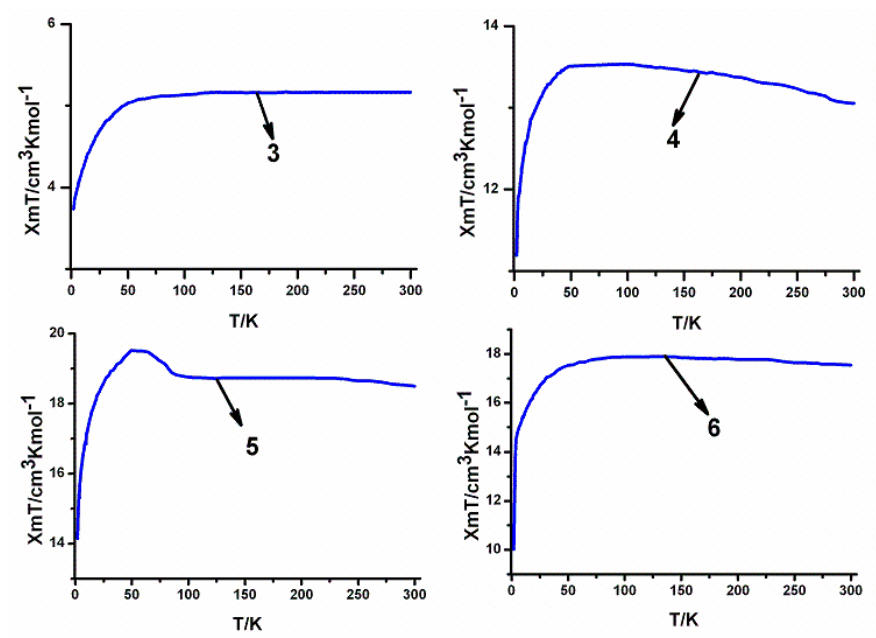
Figure 8. Temperature dependence of the χ m T curves at 1000 Oe for the series of heterotrinuclear compounds 3 – 6 .